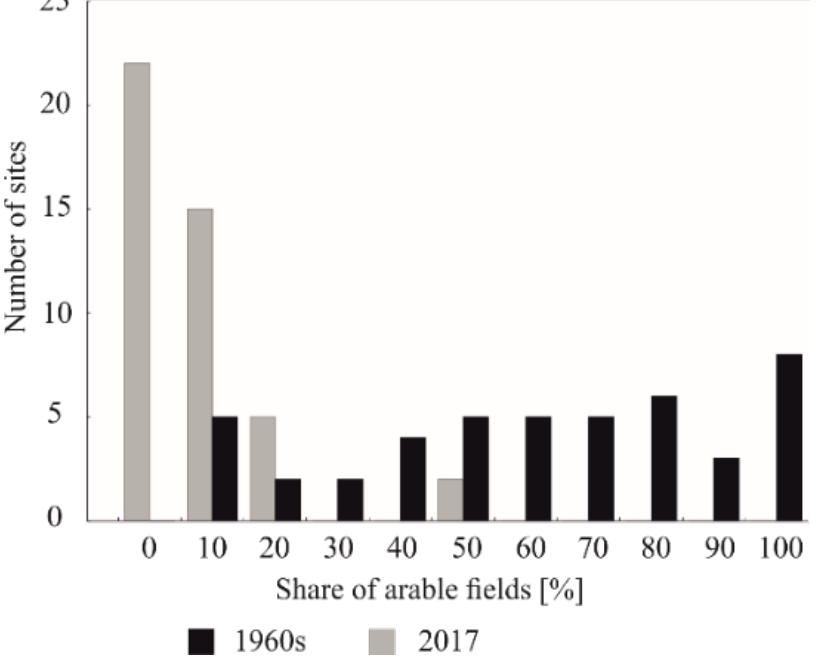
Figure 3. Number of grazing sites in classes of arable field area in the 1960s and in 2017.